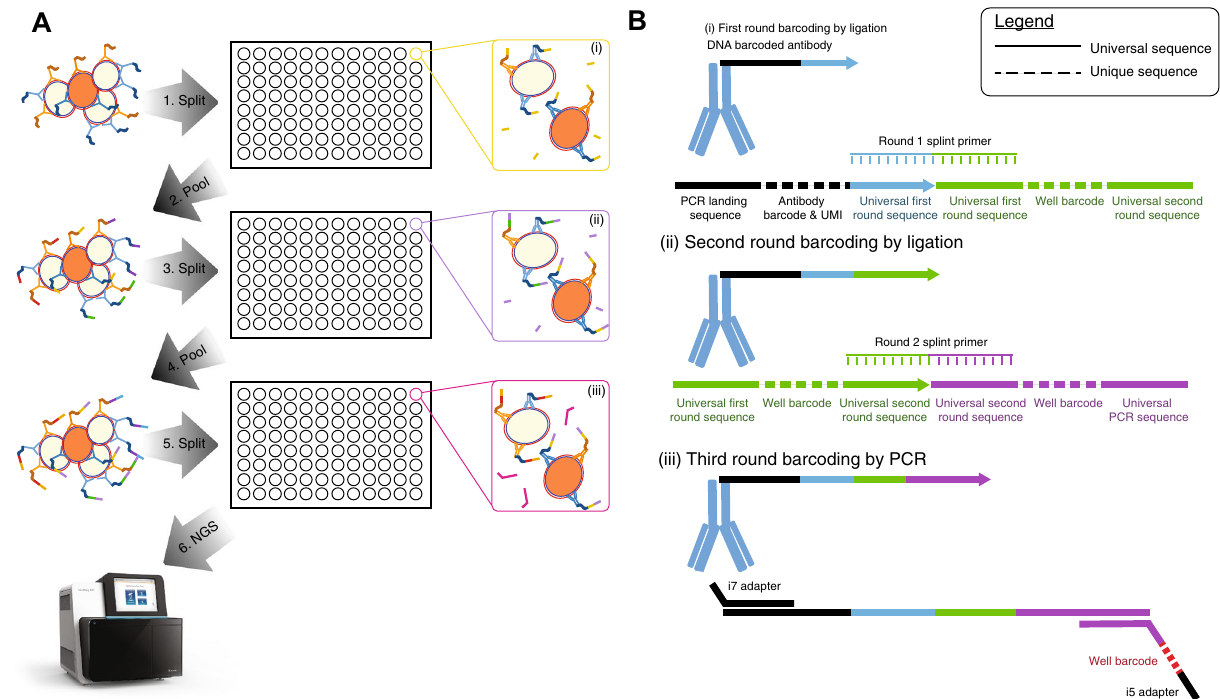
Figure 1. Schematic of QBC2 experimental design. ( A ) Cells are stained collectively with a curated panel of DNA-barcoded antibodies. Stained cells go through a series of split and pool steps where a unique well barcode is appended to the 3 ′ end of the DNA barcode. A single cell (orange) has been highlighted for clarity as it travels through the barcoding process. ( B ) Schematic of the design of the DNA barcode. First round (i) and second round (ii) well barcodes are appended to the DNA tag that is conjugated to an antibody during the two initial rounds of ligation. During the ligation steps, a splint primer is used to bring the two oligos in proximity to each other and to allow T4 DNA ligase to perform DNA ligation 21 . Third round barcodes (iii) are added through PCR before libraries are prepared for